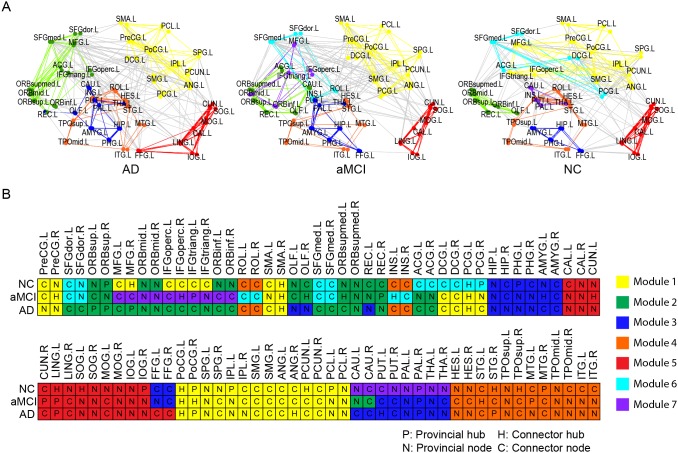
The modular structure of group averaged functional brain network at S = 10%.(A) Color coded modular structure plotted in the anatomical space. The brain network is presented with the frontal cortex on the left of the panel and the occipital region on the right of the panel. Inter-modular links are colored in gray for better illustration. Detailed information about the module regions and regional node roles for AD, aMCI and NC groups are presented in (B). The module order was determined according the descending order of the region numbers in AD group. The topological representations were drawn by the Pajek (http://pajek.imfm.si/doku.php). For the abbreviations of cortical regions, see Table S1. L = left; R = right.